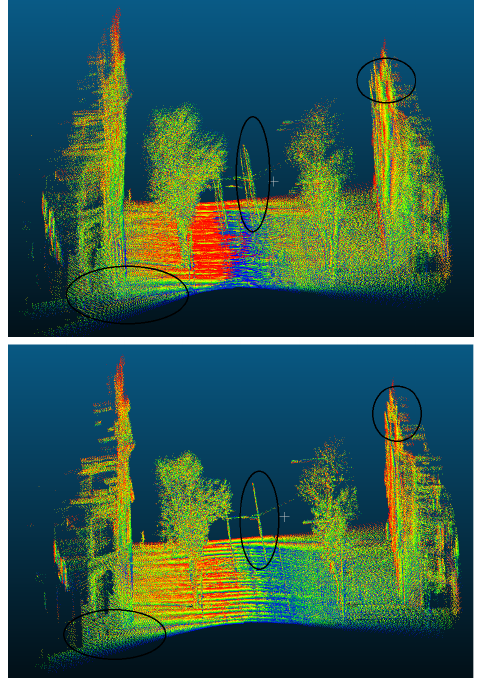
Figure 9. Real point cloud #3: top, before optimization of the parameters; bottom, after optimization. The two images have the same point of